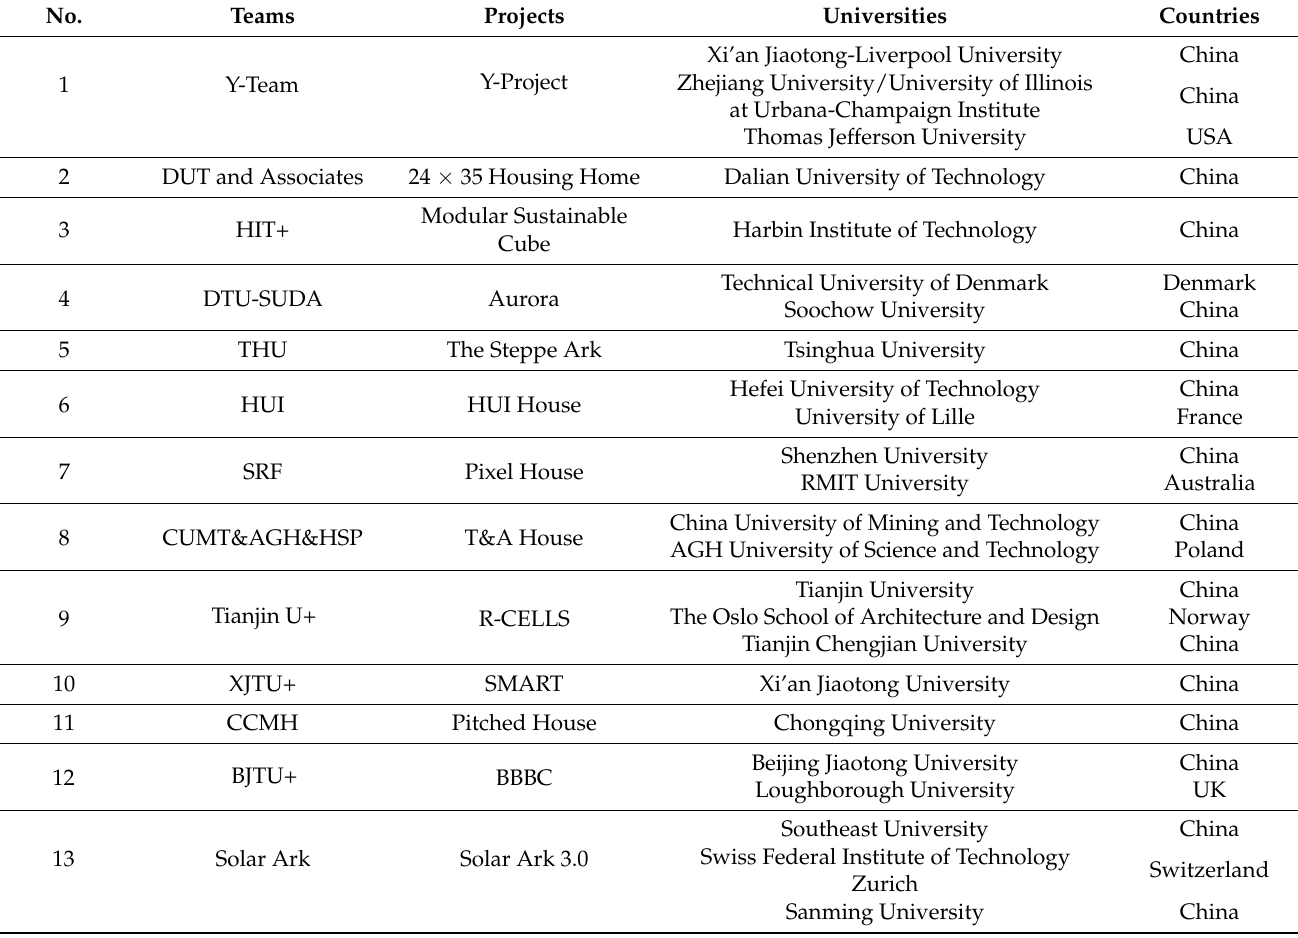
Table 1. Information regarding the 15 competition buildings and